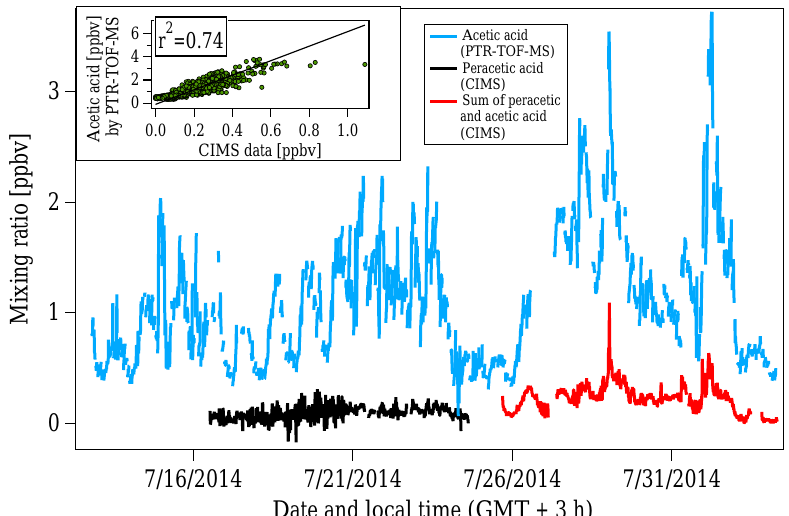
Figure 2. Time traces of peracetic acid (black) and the sum of peracetic and acetic acid (red) measured by CIMS as well as acetic acid measured by PTR-TOF-MS (10min mean values). The upper left plot shows the correlation between PTR-TOF-MS and CIMS data from 26 July to the end of the